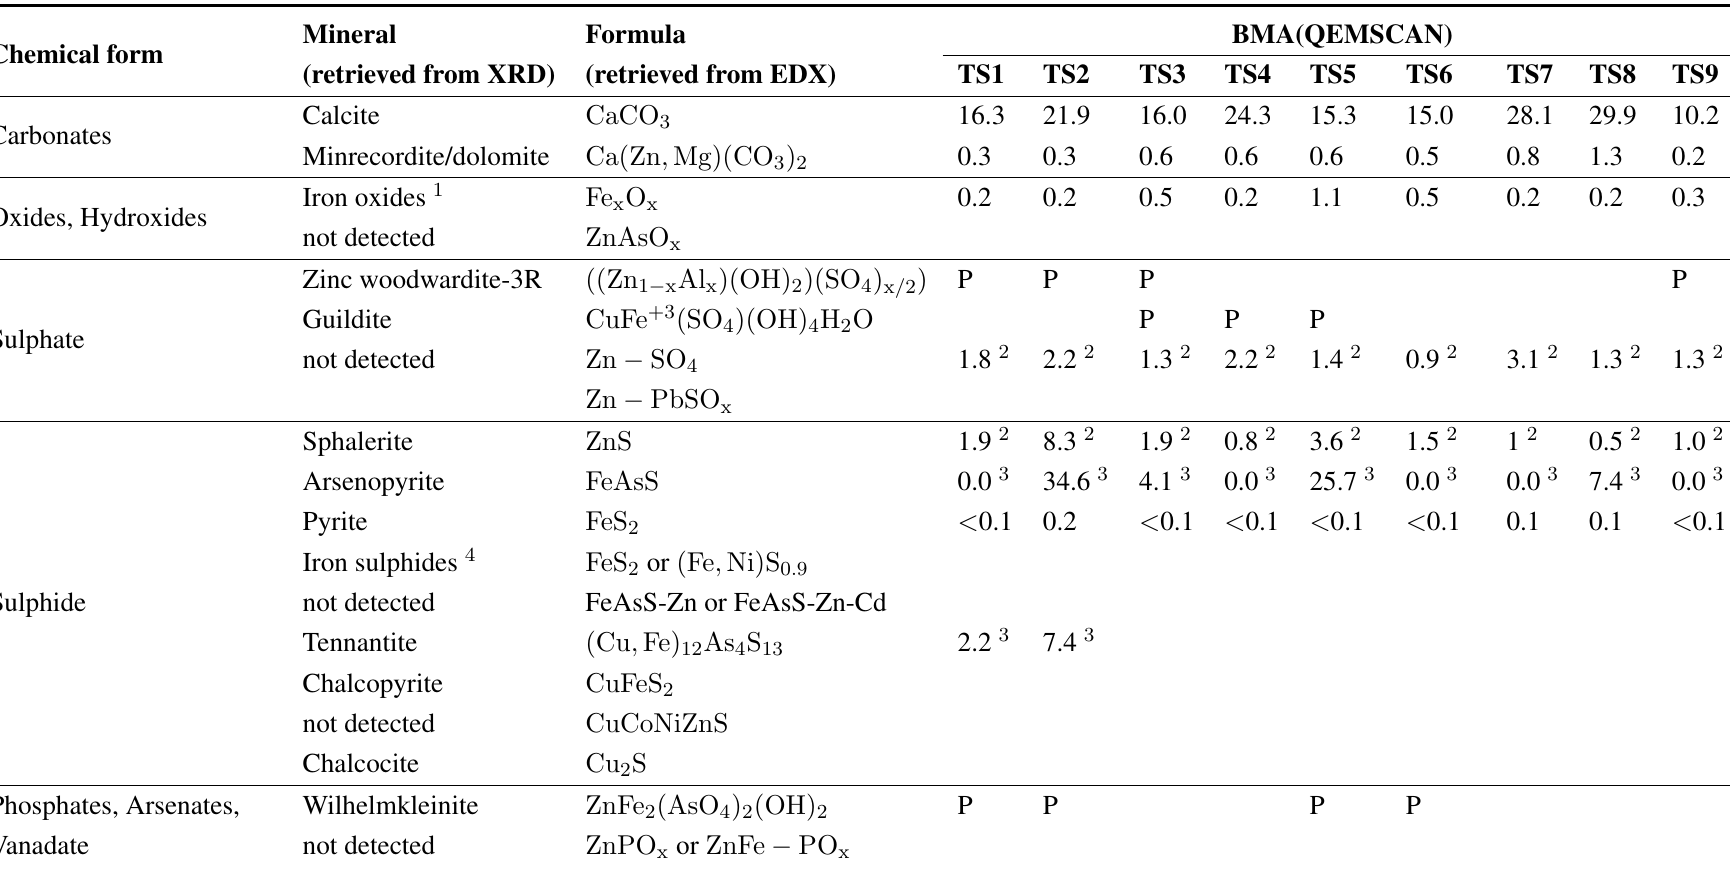
Table 2. Mineralogical composition of the biochemical reactor (BCR) samples as determined by XRD, energy dispersive X-ray (EDX) and quantitative evaluation of minerals by scanning electron microscopy (QEMSCAN). BMA, bulk mineral analysis (percent weight of the total sample, unless otherwise